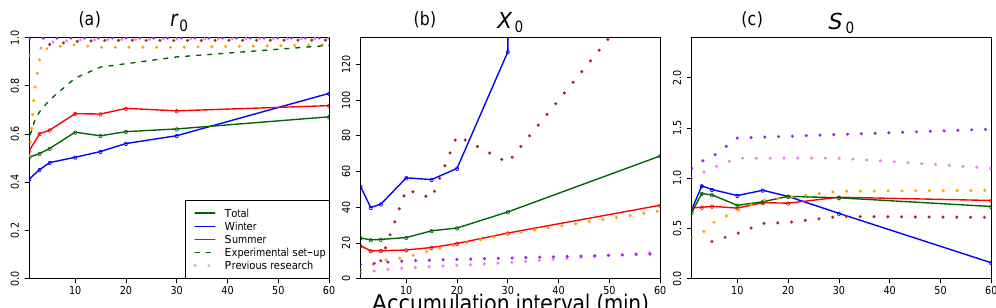
Figure 12. Timescale dependency of nugget (a) , correlation distance (b) and shape factor (c) parameters from fit described in Eq. (2), for the total PWS dataset, as well as winter and summer only. Dotted lines represent values found in previous research by Peleg et al. (2013) (violet), Villarini et al. (2008) (orange), Tokay and Öztürk (2012) (brown) and Ciach and Krajewski (2006) (purple), where the dashed line in the first panel shows the timescale dependency of the Netatmo station nugget found in the experimental setup as previously shown in Fig. 6.